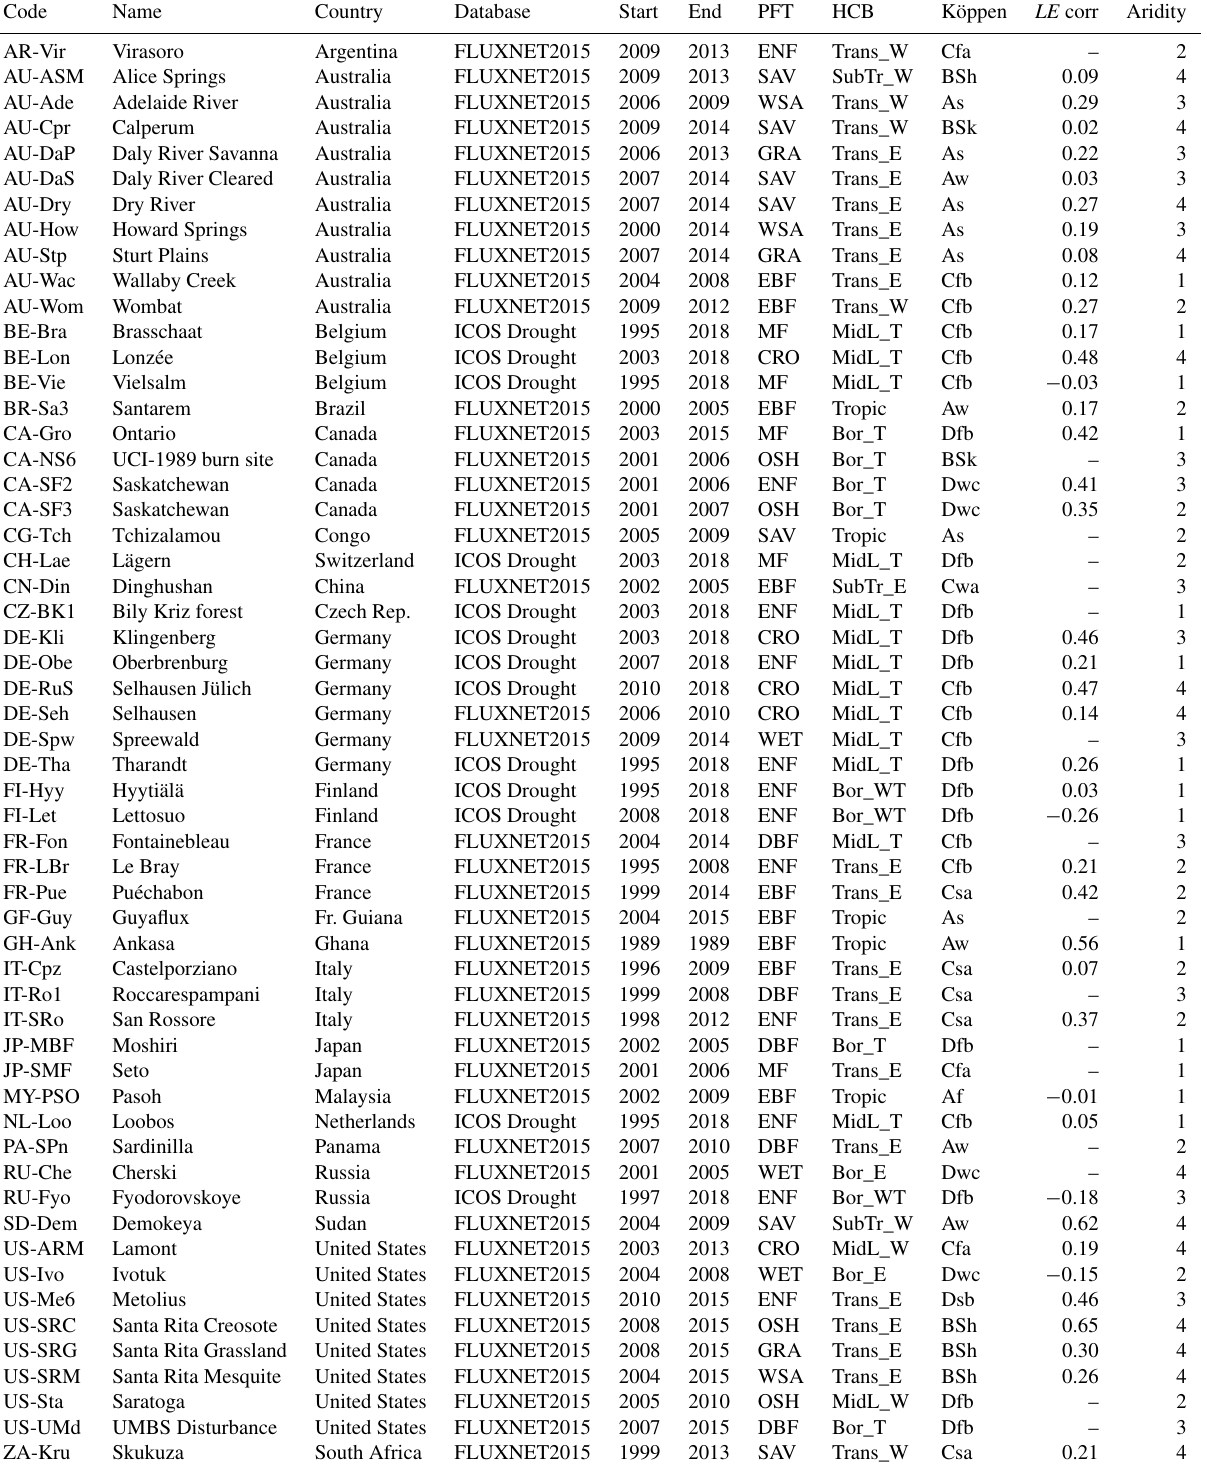
Table 2. Selection of 56 FLUXNET/ICOS sites used in this study. Classification by PFT, HCB (boreal-/mid-latitude-/transitional- /subtropical-/tropical + energy-/water-/temperature-driven) and Köppen. LE corr: relative change in the mean LE flux after correction for energy balance closure (no value: correction not available). Aridity: aridity class, derived from ISBA